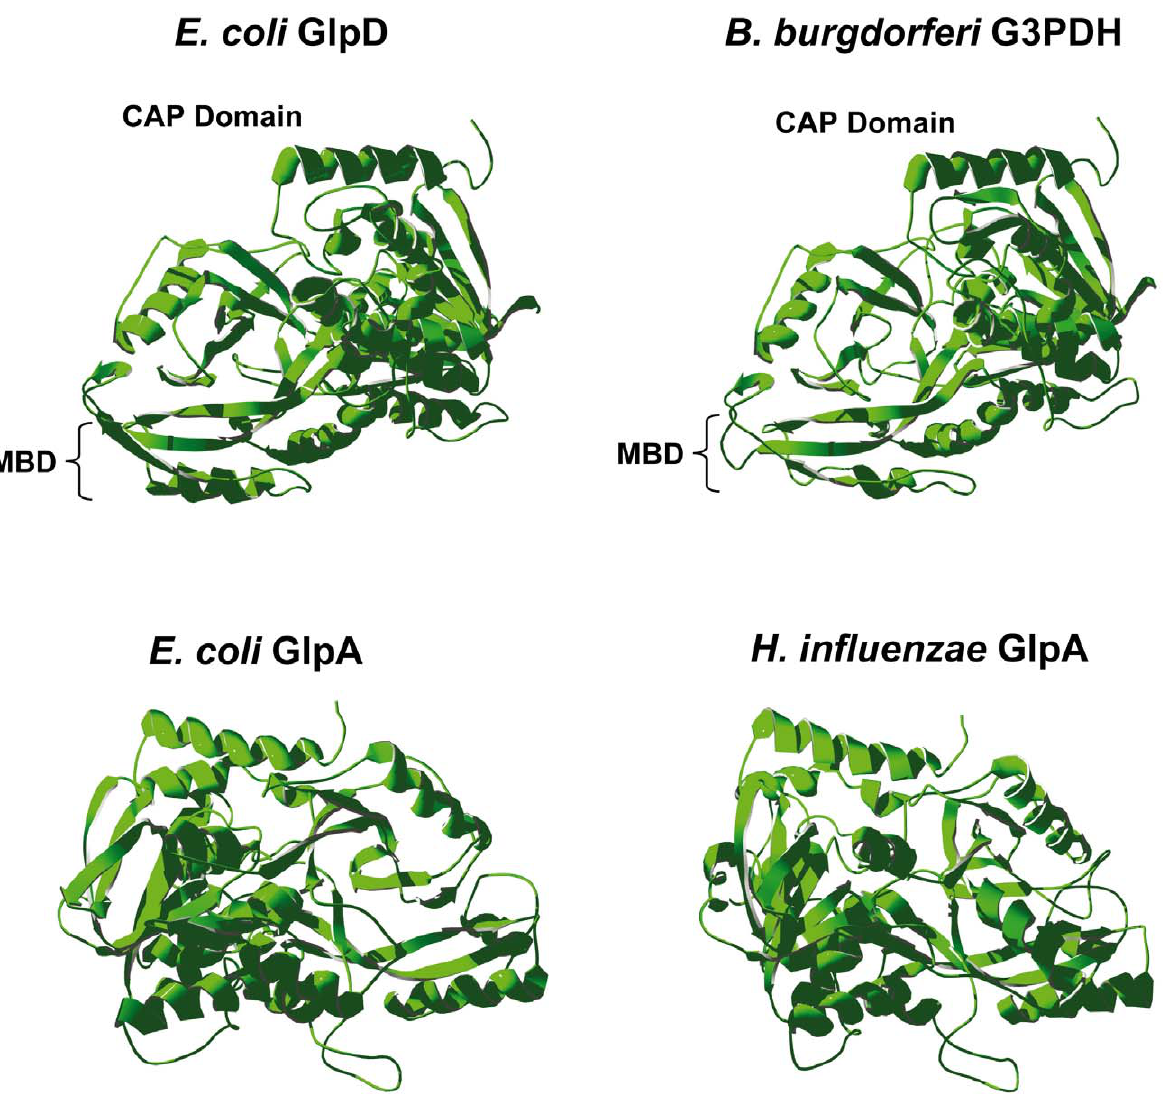
Figure 2. Predicted tertiary structure of B.burgdorferi G3PDH. The B. burgdorferi G3PDH sequence was mapped onto known bacterial G3PDH three-dimensional structures using SWISS-MODEL software. Structures were rotated so they are aligned in an identical orientation, with the C- terminal a -helix (red) at the top in all structures. MBD, putative membrane binding domain [41].